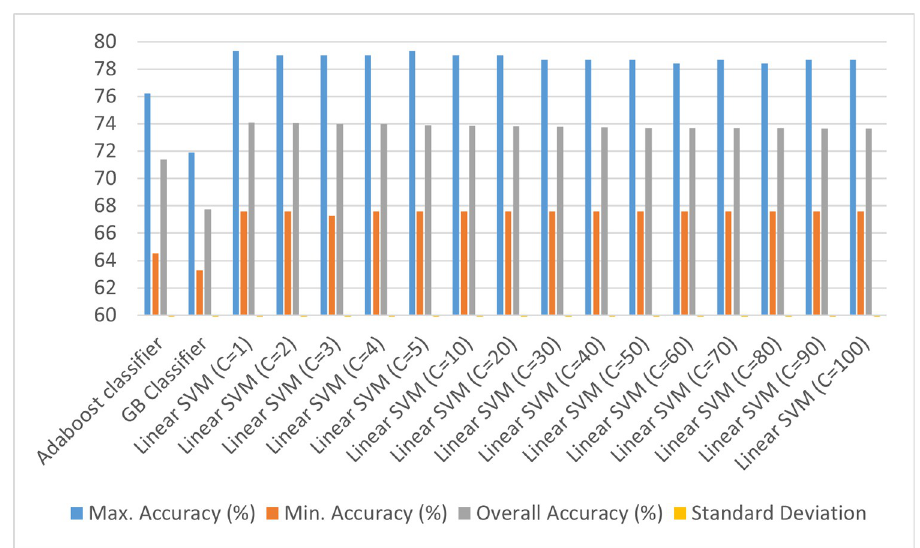
Fig 3. Classification results using quantile transformation on the dataset (applying normal quantile distribution on the dataset with the number of quantiles set to 100 and output distribution as uniform).